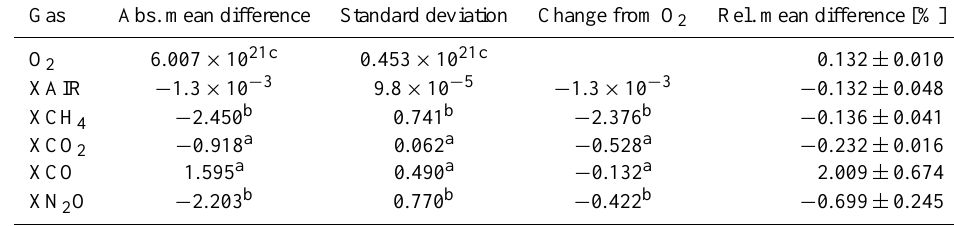
Table 1. Absolute and relative mean differences of retrieved target gases with and without a higher-order continuum fit. Gas Abs. mean difference Standard deviation Change from O 2 Rel. mean difference [%] O 2